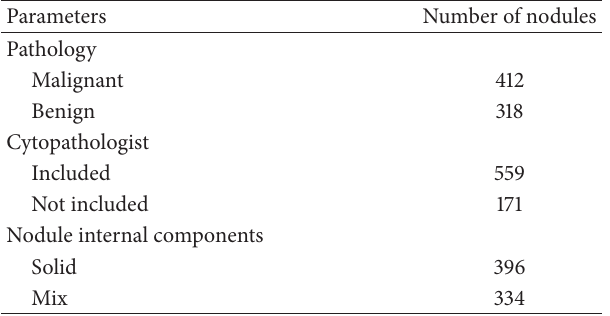
Table 3: Logistic regression analysis results regarding to the false- negative